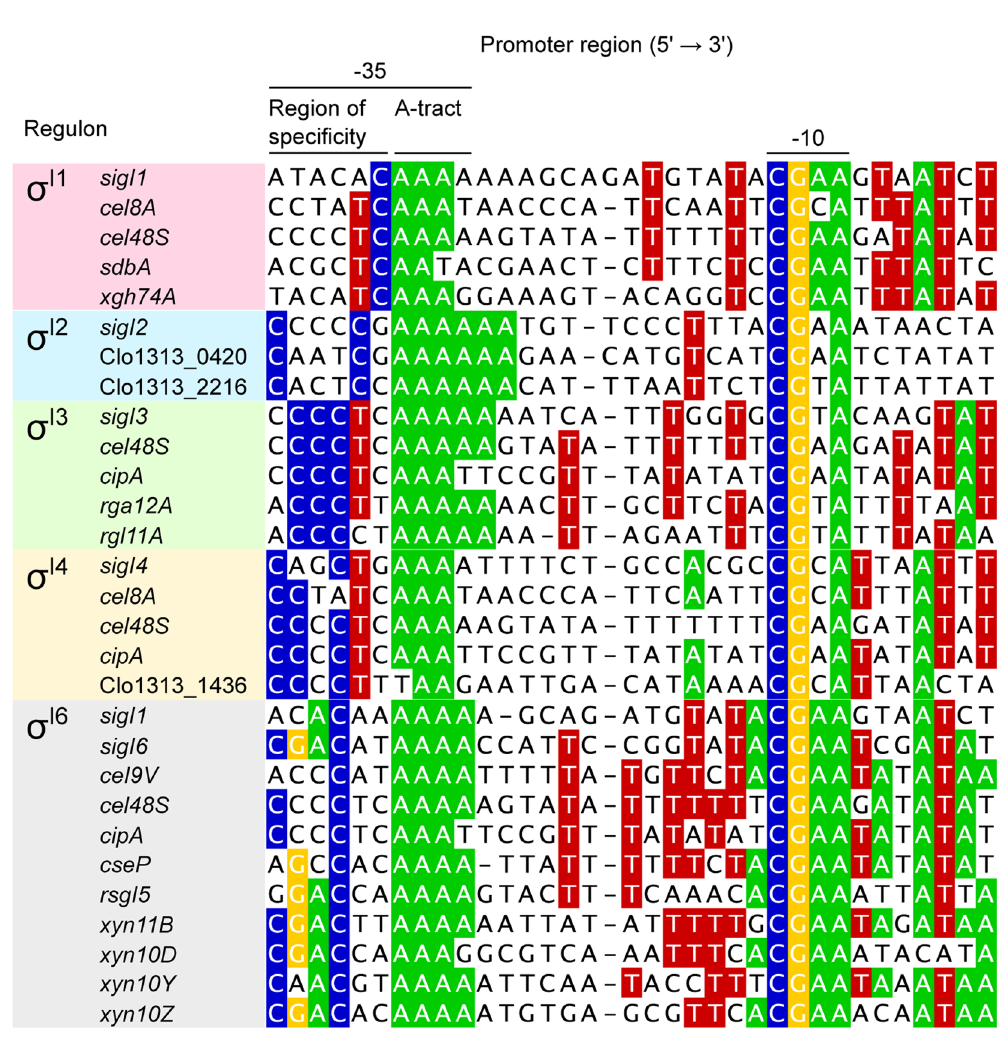
Figure 2. Dissection of C. thermocellum σ I -dependent promoters. The conservation of nucleotides shown in the alignment is divided into σ I1 -, σ I2 -, σ I3 -, σ I4 -, and σ I6 -dependent promoters. The promoter sequences of each σ I regulon were taken from Fig. 1A. The most conserved nucleotides of each σ I regulon are